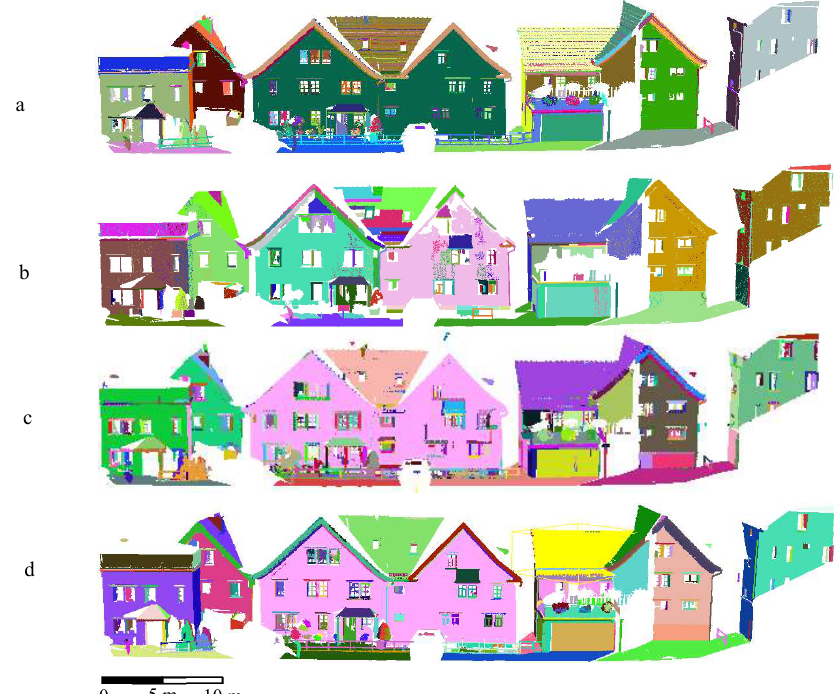
Figure 9. Segmentation results of terrestrial laser scanner data. ( a ) Segmentation results of efficient RANSAC algorithm (ER) algorithm, ( b ) segmentation results of the region growing algorithm (SCRG) algorithm, ( c ) segmentation results of VGS algorithm, and ( d ) segmentation results of the encoding